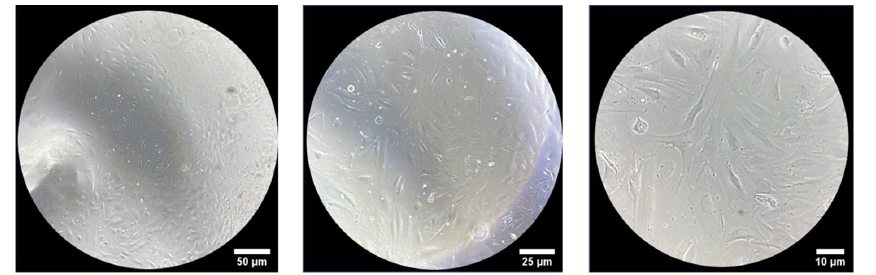
Figure 6. NHDF cells in the hydrogel observed under optical microscope (magnification 10×) after all analyzed times of incubation.